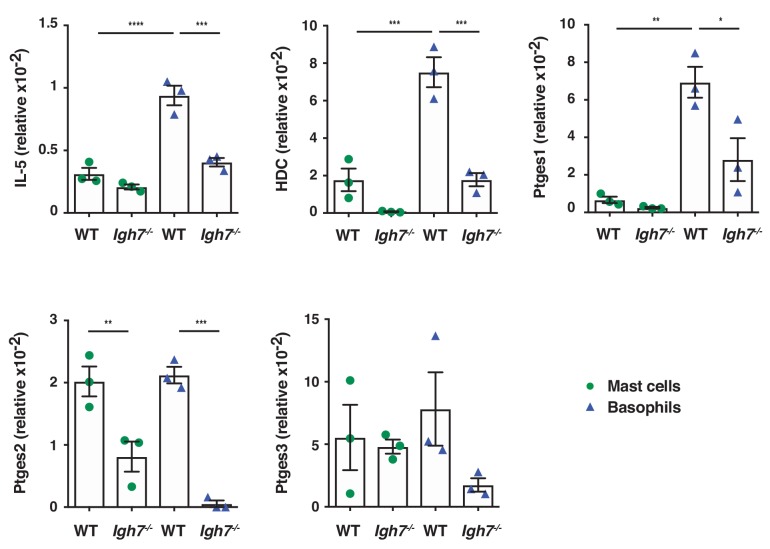
Basophils are potently immune active in inflamed skin but require IgE for full activity.Mast cells and basophils were FACS sorted from the inflamed TPA-treated skin of WT and Igh7–/– mice (topical TPA, 2x/week for 2 weeks) 72 hr after the last TPA treatment (n = 3/group). Mast cells were defined as CD45hicKit+FcεRI+CD41– and basophils as CD45locKit–FcεRI+CD41+. Quantitative RT-PCR analysis of the indicated transcripts in the FACS-sorted cell populations are shown relative to the control gene cyclophilin. All data are expressed as means ± SEM. Statistical analysis was performed by one-way ANOVA multiple comparison; *p<0.05, **p<0.01, ***p<0.001 and ****p<0.0001.